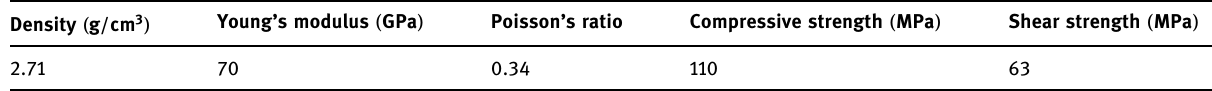
Table 1: Mechanical properties of the aluminum alloy Density ( g cm 3 /